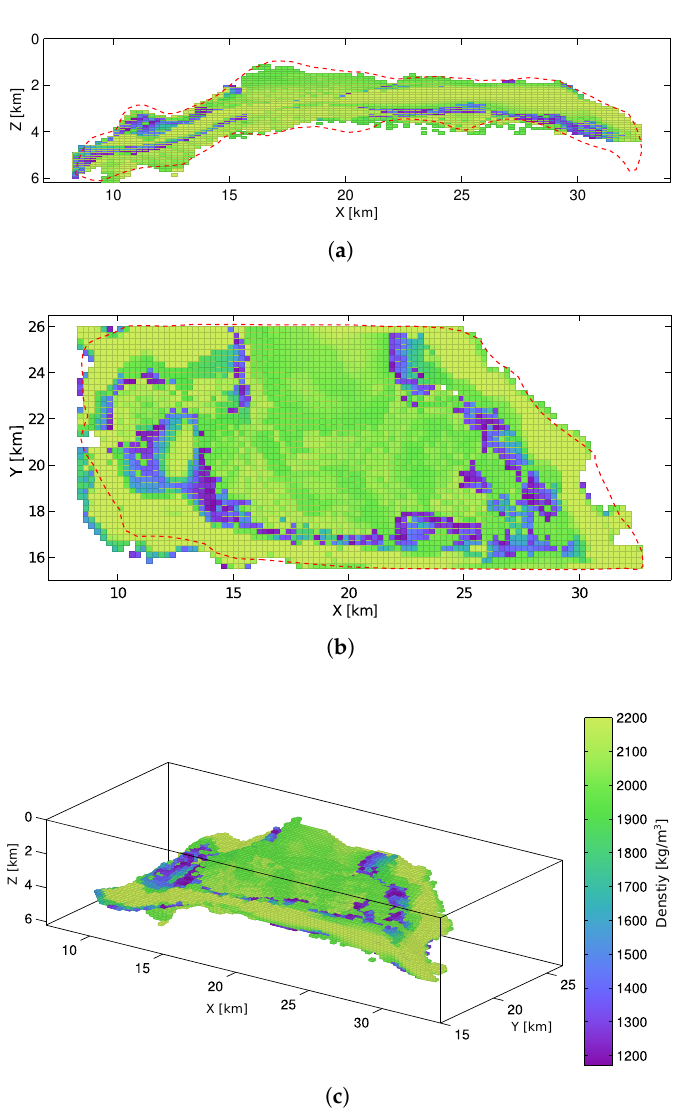
Figure 29. Final gravimetric model for the inversion for the salt body. ( a ) XZ view. The red dotted line represents the limits of the real model (Figures 7 and 8). ( b ) XY view. The red dotted line represents the limits of the real model (Figures 7 and 8). ( c ) Three-dimensional view.